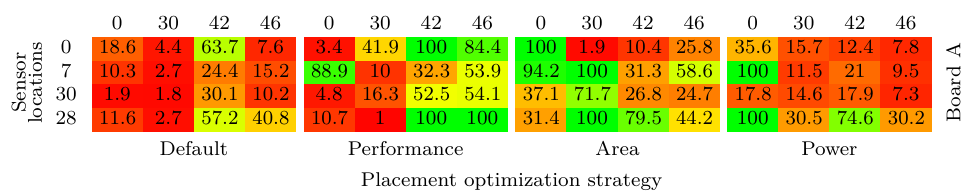
Figure 12: Minimum amount of traces ( × 1 , 000) required for a successful attack on board A without the RO-based countermeasure